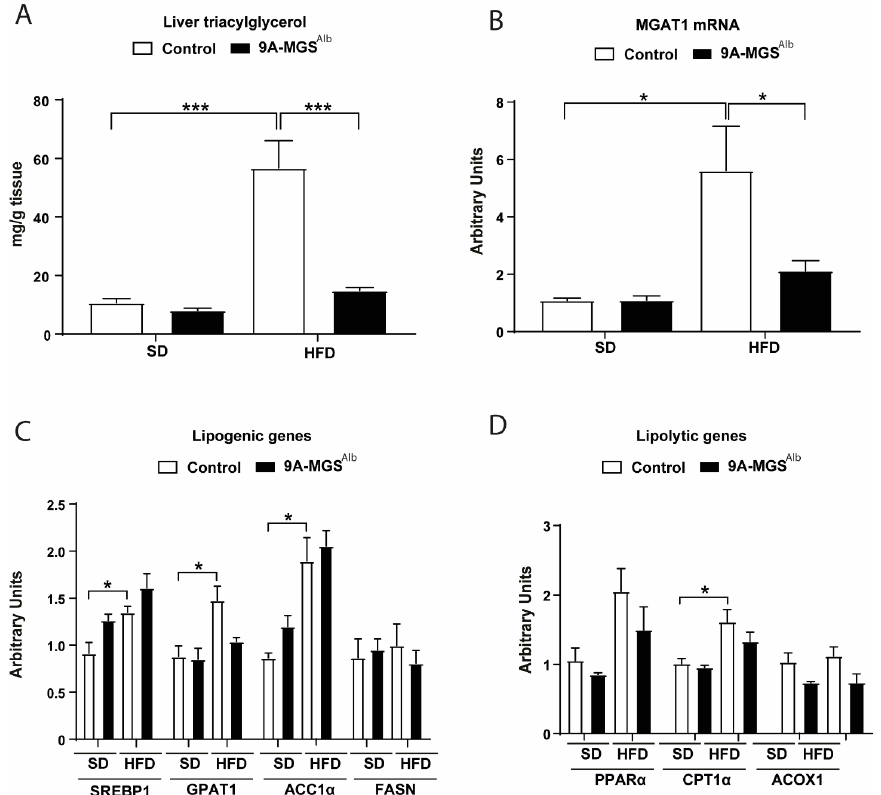
Figure 5. ( A ) Liver triacylglycerol in fed condition. ( B ) Quantitative real-time PCR showing relative mRNA levels of MGAT1 in the livers of mice fed an SD or HFD. ( C ) Quantitative real-time PCR showing relative mRNA levels of SREBP1, GPAT1, ACC1 α , and FASN in the livers of mice fed an SD or HFD. ( D ) Quantitative real-time PCR showing relative mRNA levels of PPAR α , CPT1 α , and ACOX1. Data are mean ± SEM. n = 5 – 7/group. * p < 0.05, *** p < 0.001.